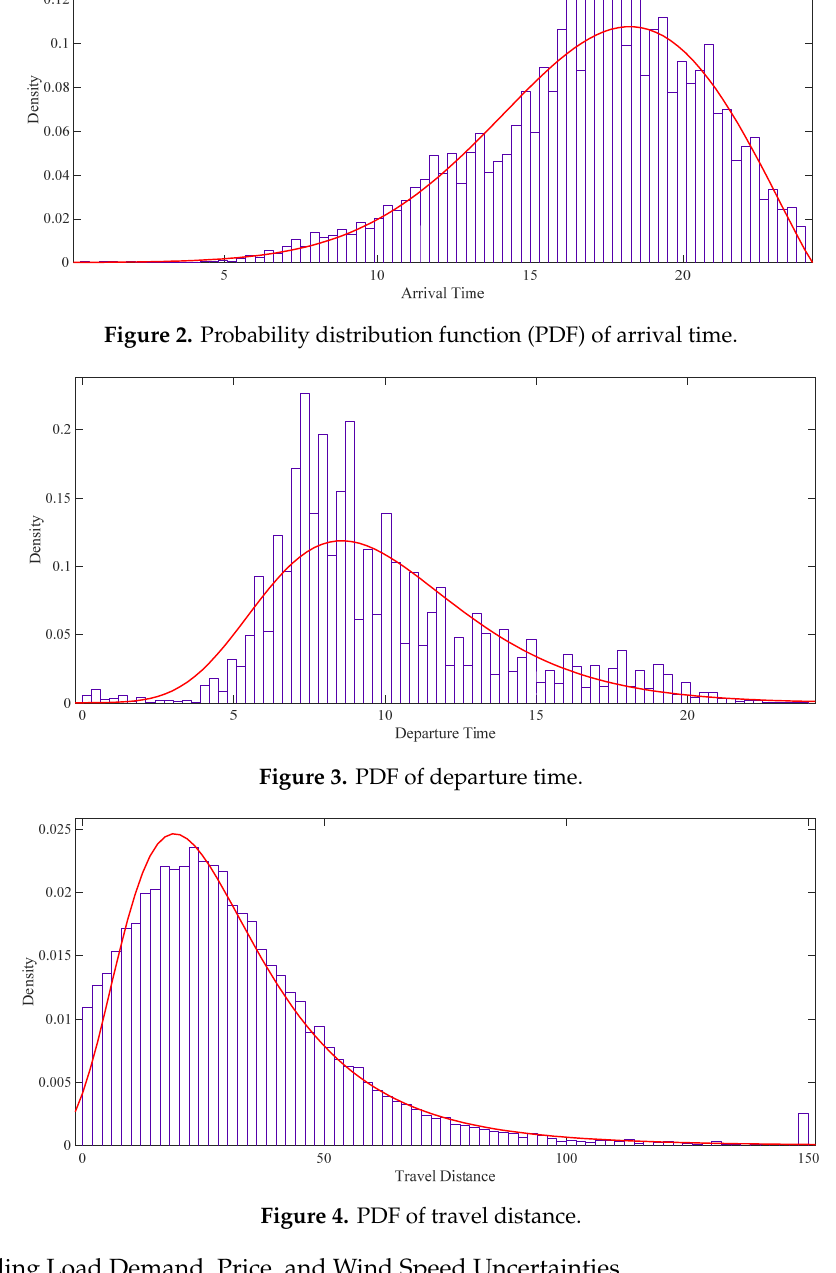
Table 1. Distribution function parameters of the travel behavior uncertainties.